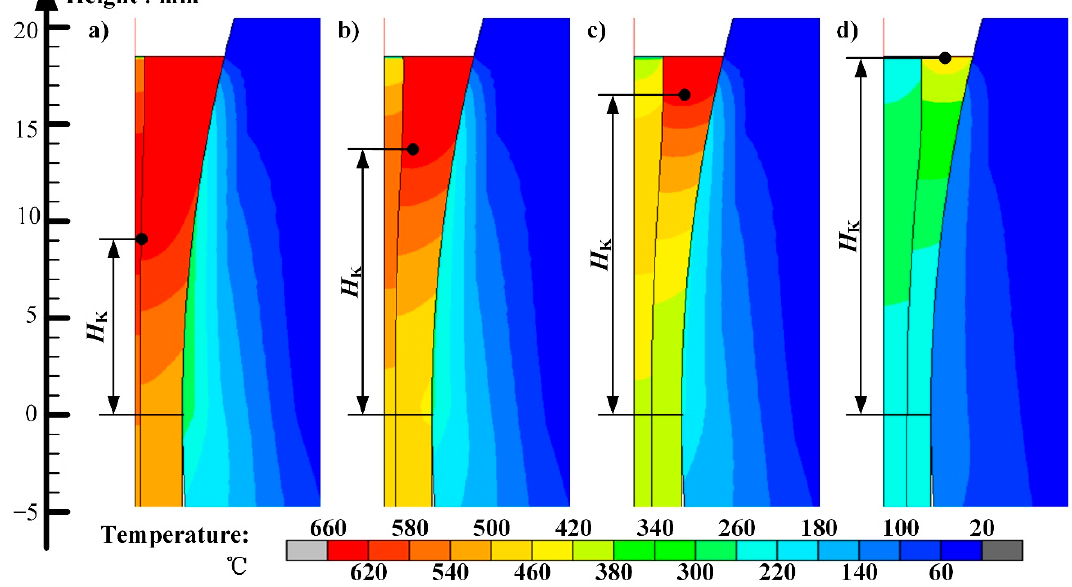
Figure 11. Contour bands of LSL-TRC temperature distribution with different core thickness. ( a ) H 3003 = 1.0 mm; ( b ) H 3003 = 2.0 mm; ( c ) H 3003 = 3.0 mm; ( d ) H 3003 = 4.0 mm.